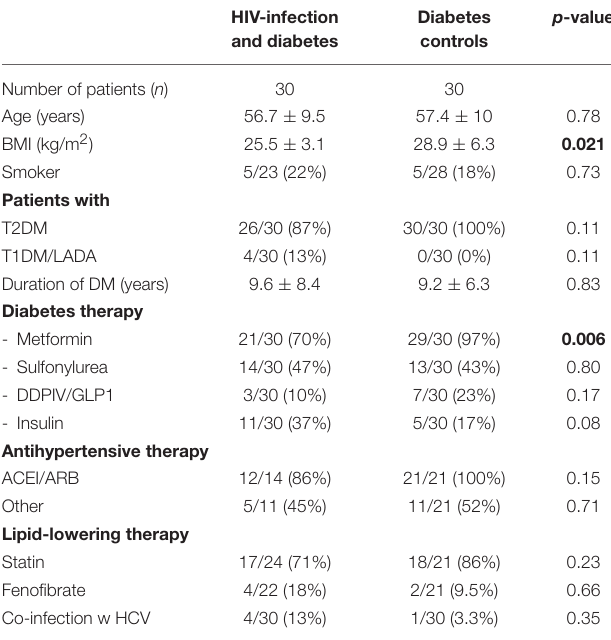
TABLE 1 | Demographic data of diabetes clinic attendees with HIV-infection and diabetes vs. diabetes